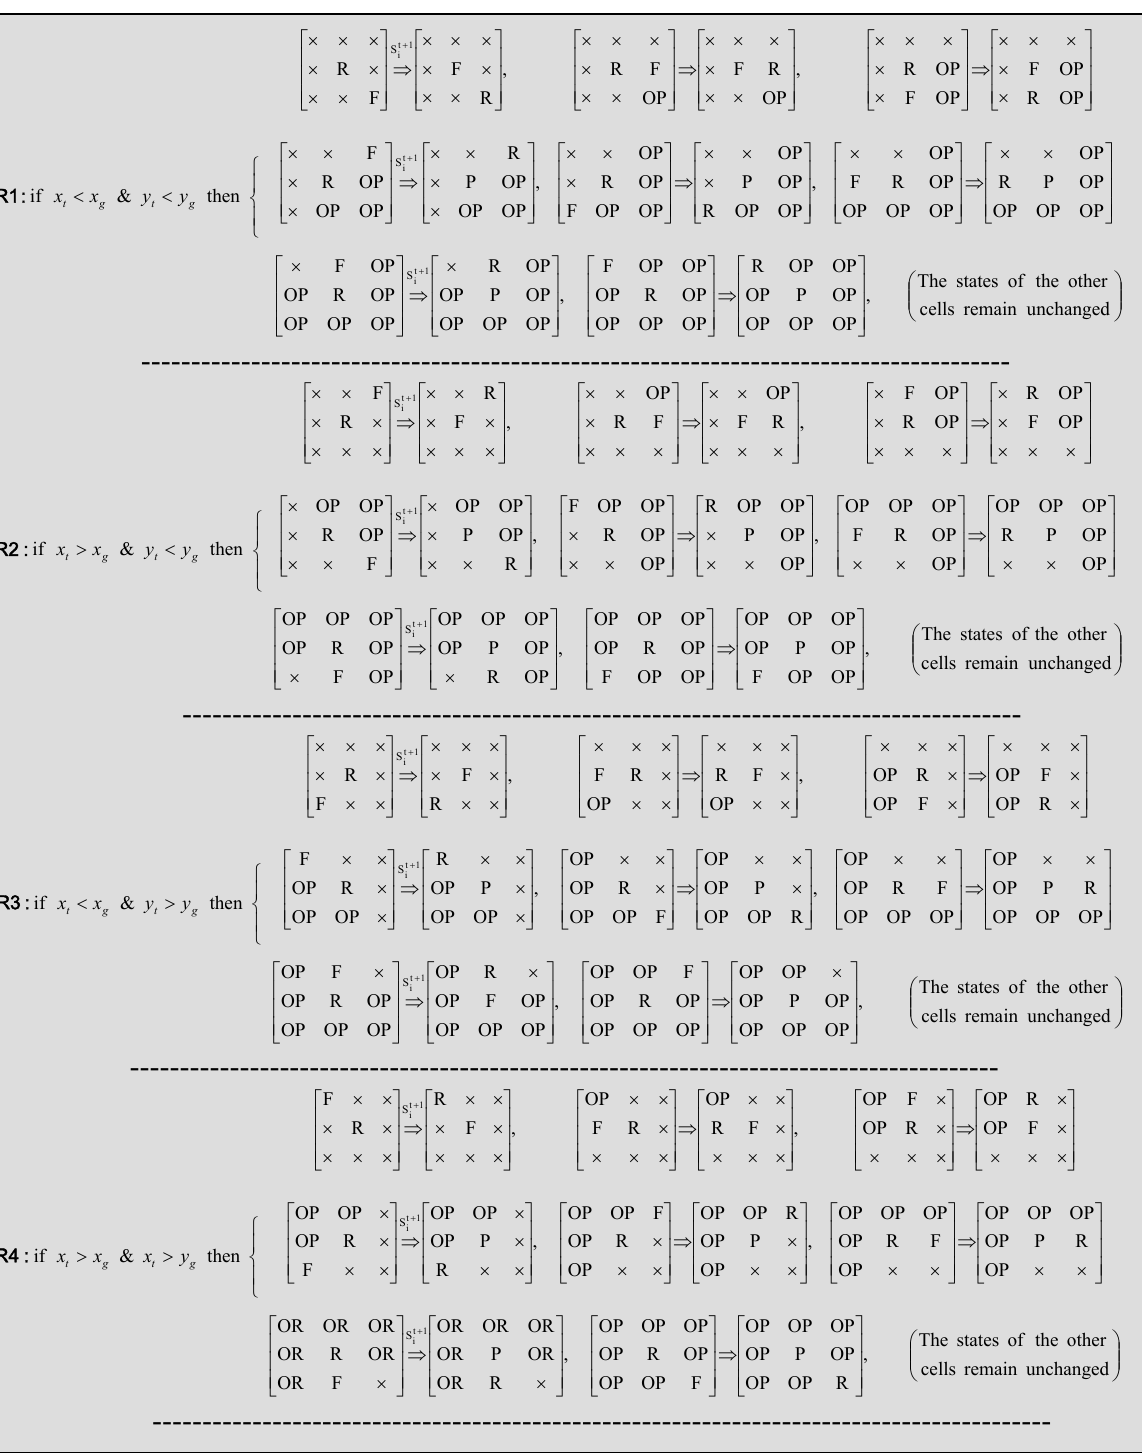
Fig. 7. The rules for the path-planner cellular automata modified by ant colony inspired method. At each time step t only one of the rules is active. In these rules, (x t ,y t ) is position vector of robot at time t and (x g , y g ) is the position vector of goal cell. Symbol × denotes the cells those states do not important at time step t and OP means: Obstacle cell ∨ Pheromone